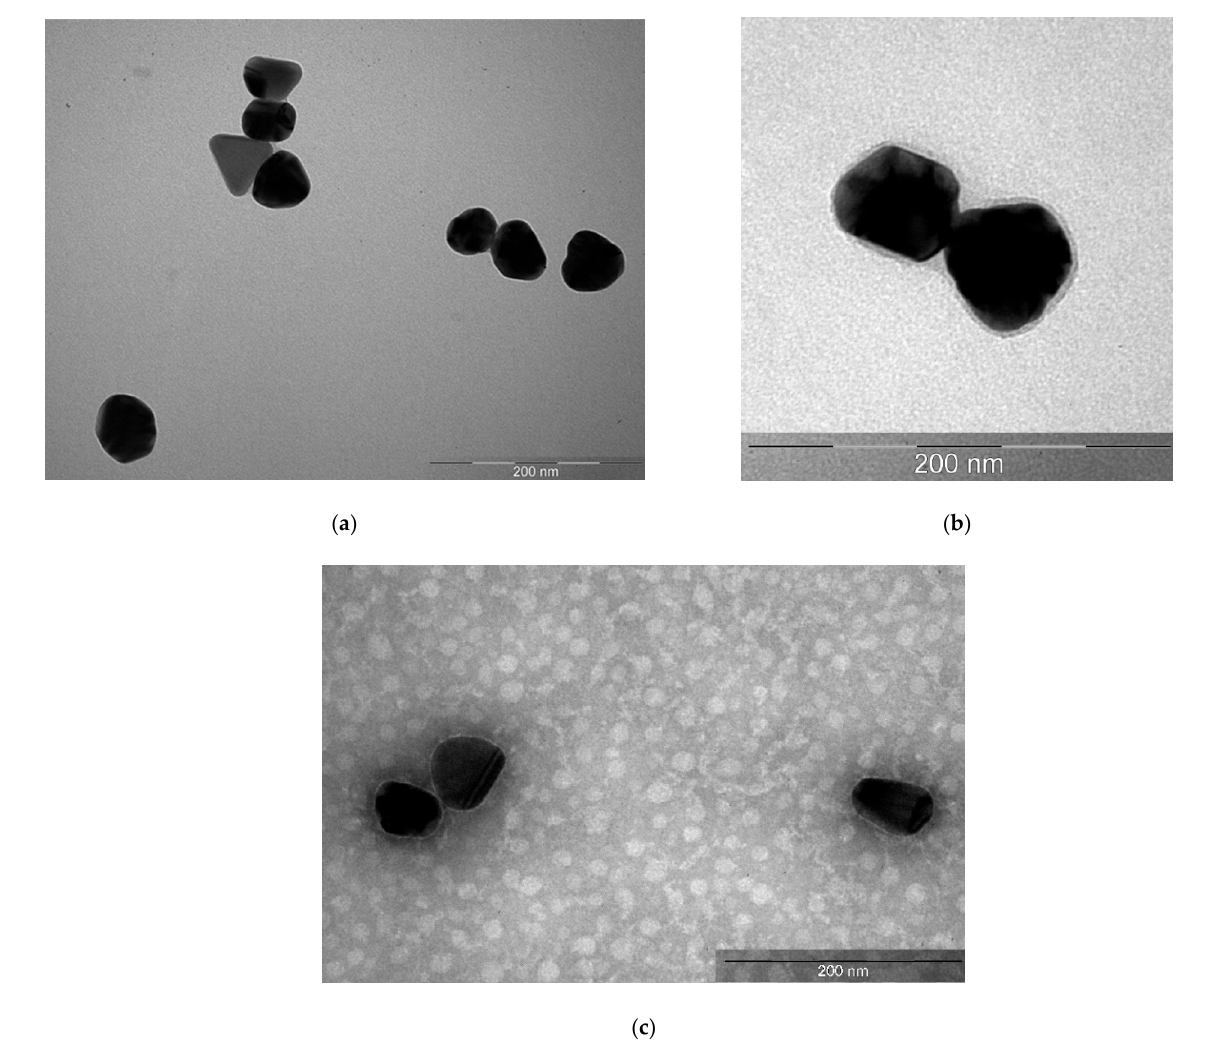
Figure 3. TEM photographs of ( a ) silver nanoparticles, ( b ) polysorbate-80-coated silver nanoparticles, and ( c ) albumin-coated silver nanoparticles.